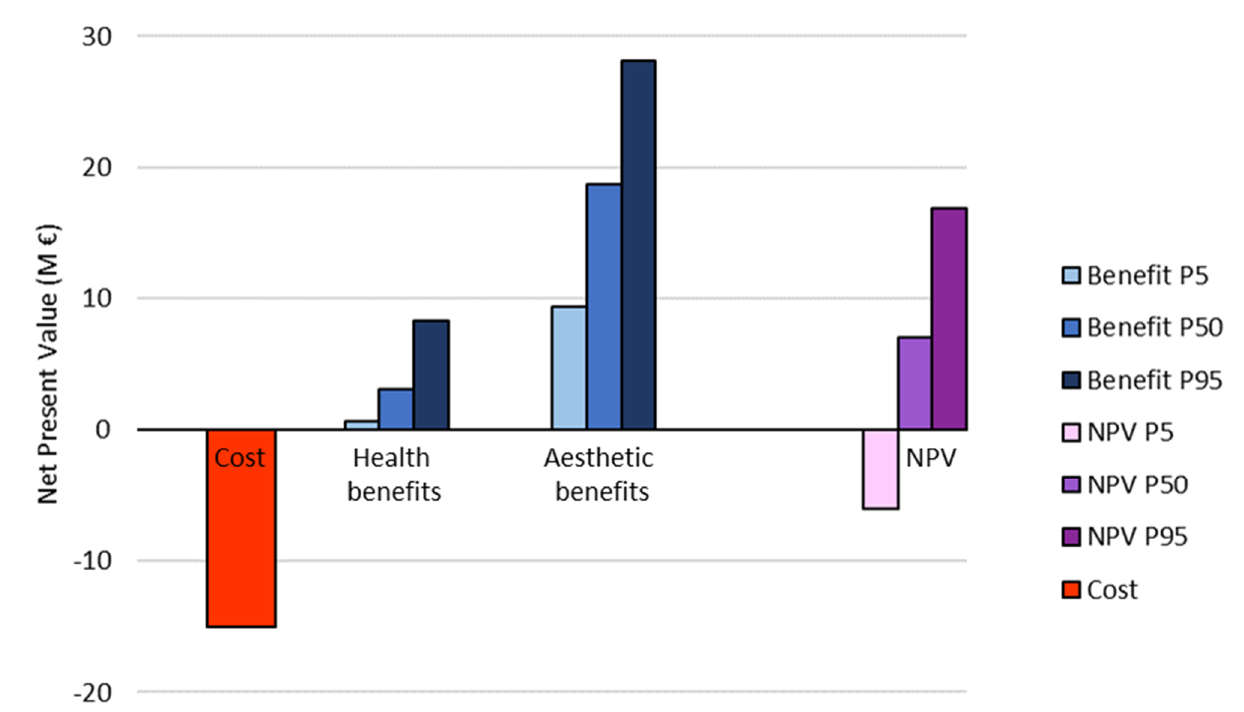
Figure 5. Bar chart of the UF membrane calculated costs, benefits, and NPV, for a 50 year time horizon at a 3.5% discount rate. The uncertainty of the calculated benefits and NPV is illustrated using their 5, 50, and 95 percentile value.